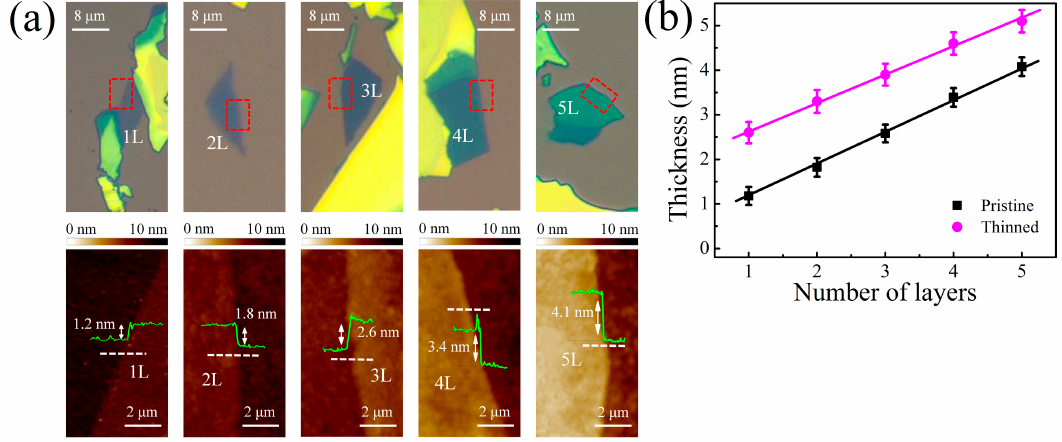
Figure 1. ( a ) Optical images and the corresponding AFM images of monolayer (1L) to pentalayer (5L) pristine MoTe 2 flakes on SiO 2 / Si substrate. The regions enclosed by the red dashed lines indicate the AFM scanned areas. The green curves are AFM height profiles taken along the white dashed lines on the AFM images. ( b ) Plots of thickness of pristine and thinned MoTe 2 versus layer number. Solid lines are linear fits.